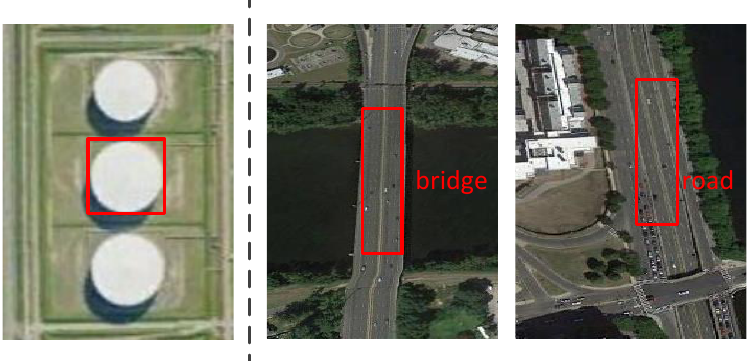
Figure 1. Examples difficult to detect. ( Left ) Only using the sample appearance features in the red rectangle, just a circle, is hard to identify the storage tank. ( Right ) The bridge and the road are easily